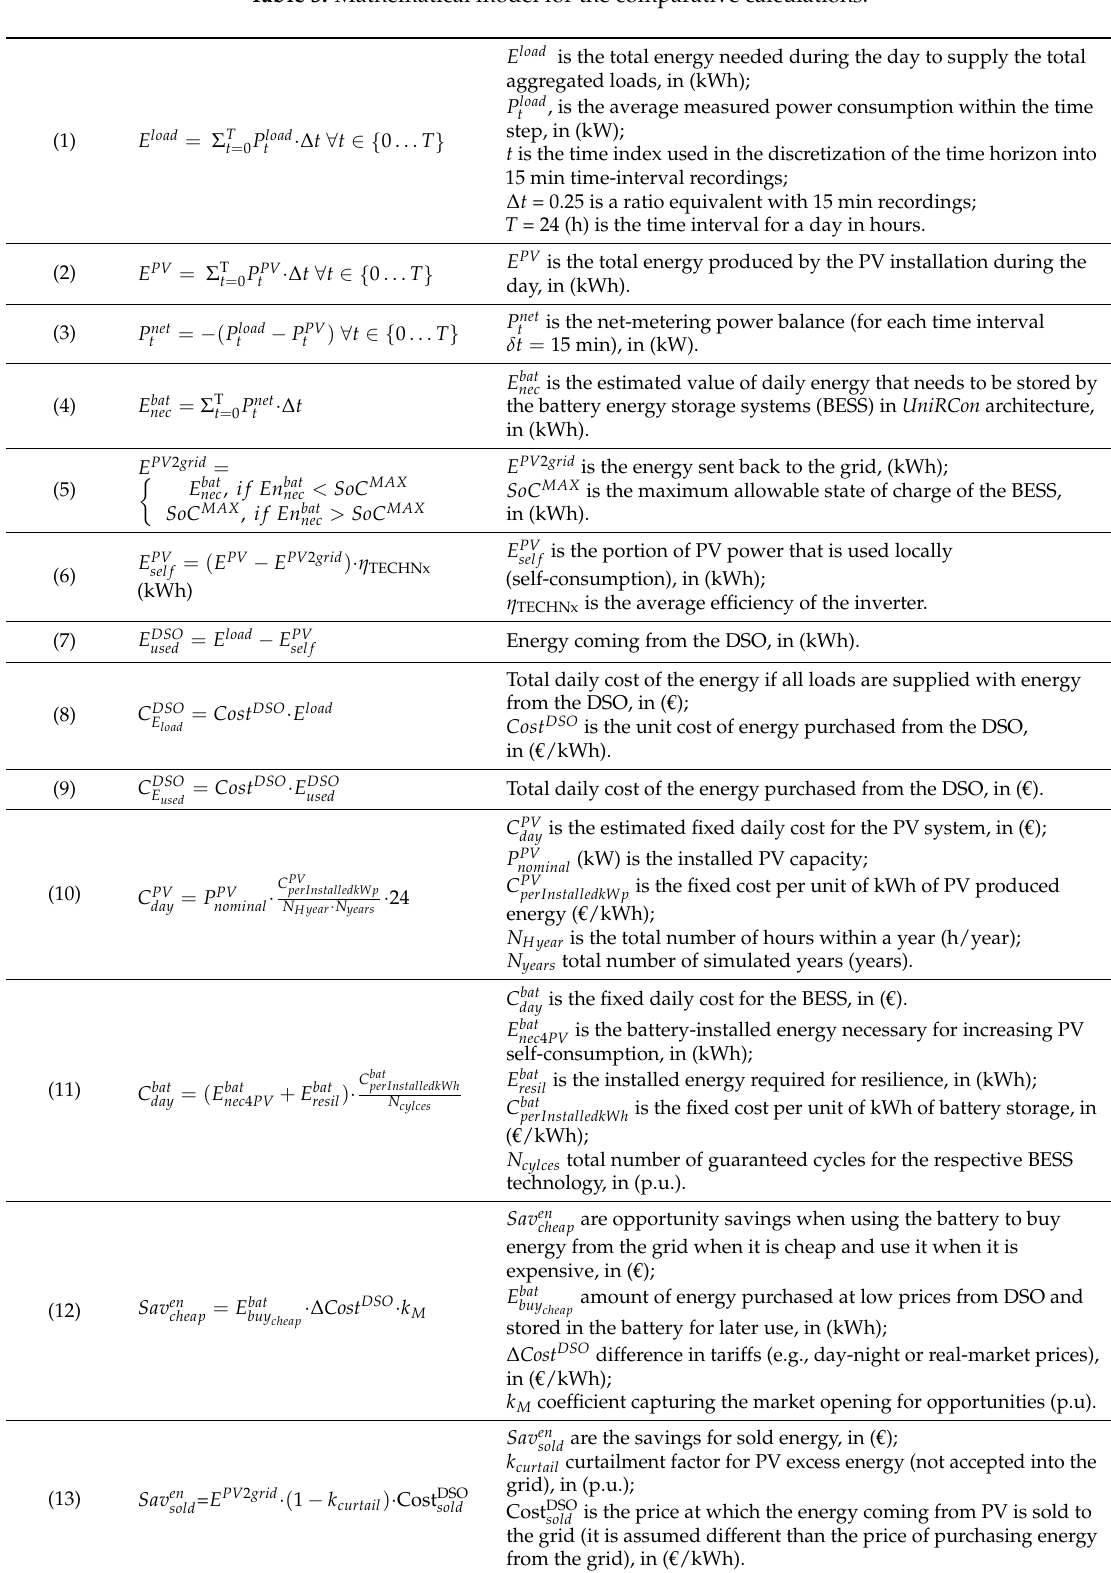
Table 3. Mathematical model for the comparative